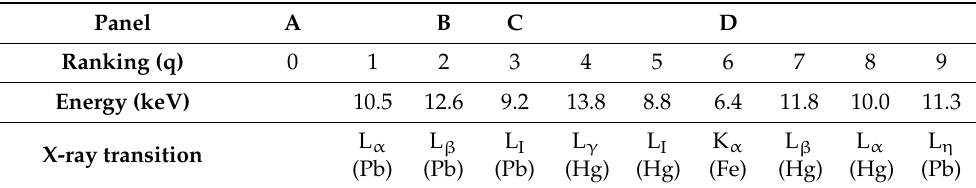
Table 3. The principal energies (i.e., elements’ emission series) emerging from the GS relating to the reference panel data. The series has been ordered following their abundance from the most to the less detected. The energy of the emission has been reported in keV and classified according to the X-ray nomenclature. The letters refer to Figure 4 and specify the series that have been removed before the calculation of the corresponding set of similarity